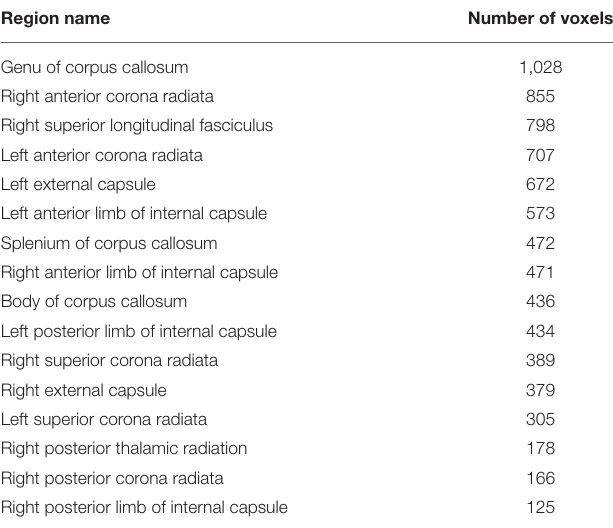
TABLE 2 | Number of voxels for significant clusters of RK ×